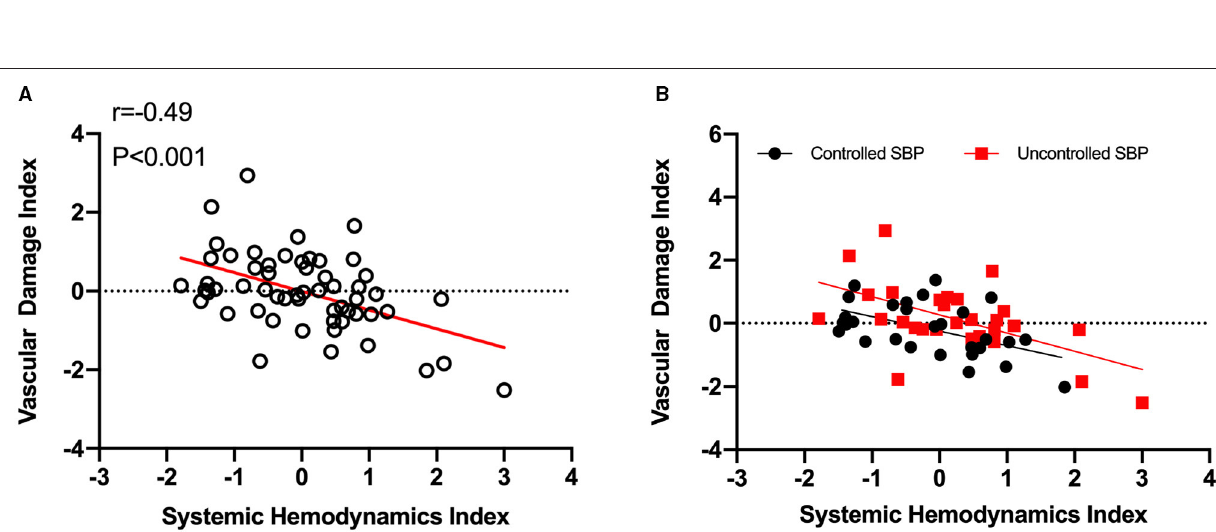
FIGURE 3 | Development of surrogate marker for systemic hemodynamics management. (A) A PCA-based method recognized the SHI (principal component 1) as an accounting score. (B) A positive and significant correlation of FMD with SHI was displayed ( n = 65). (C) Consistently, the SHI was negatively correlated to baPWV levels ( n = 63). PCA, principal component analysis; FMD, flow-mediated dilation; baPWV, brachial-ankle pulse wave velocity.